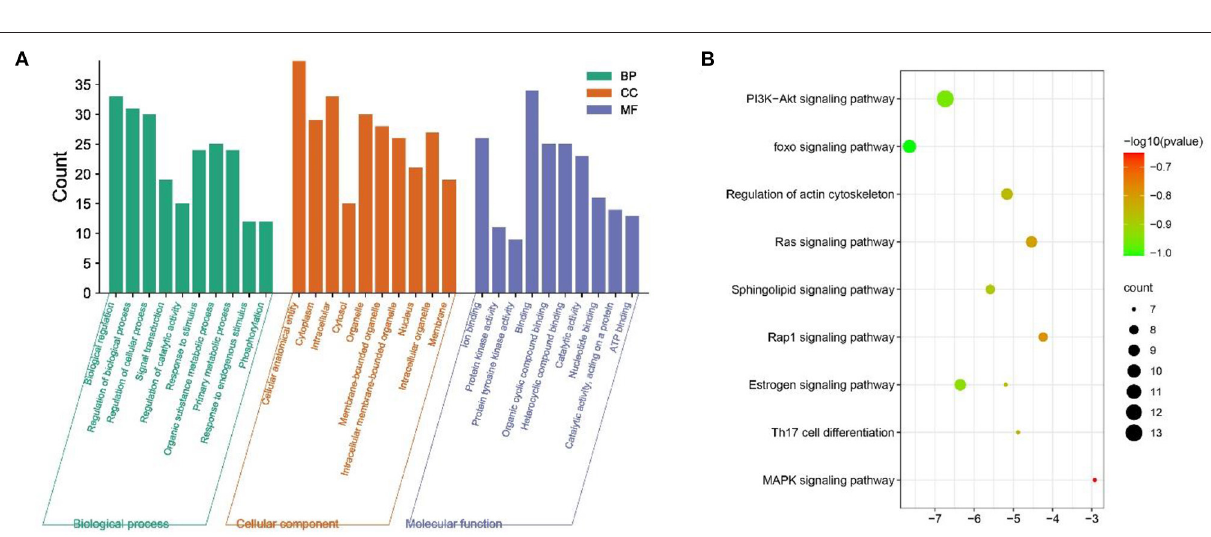
FIGURE 5 | Analysis of functional processes and molecular pathways. (A) Top 10 Go features according to P -value. The bars represent the GO functions enriched to the intersection target proteins, the horizontal coordinate is sorted according to the P -value, and the vertical coordinate indicates the number of intersection targets present in the current GO function. (B) Top 10 KEGG pathways according to P -value. The circle represents the KEGG description on the left, the shade of color indicates the P -value, and the size indicates the number of intersecting targets present in the current KEGG